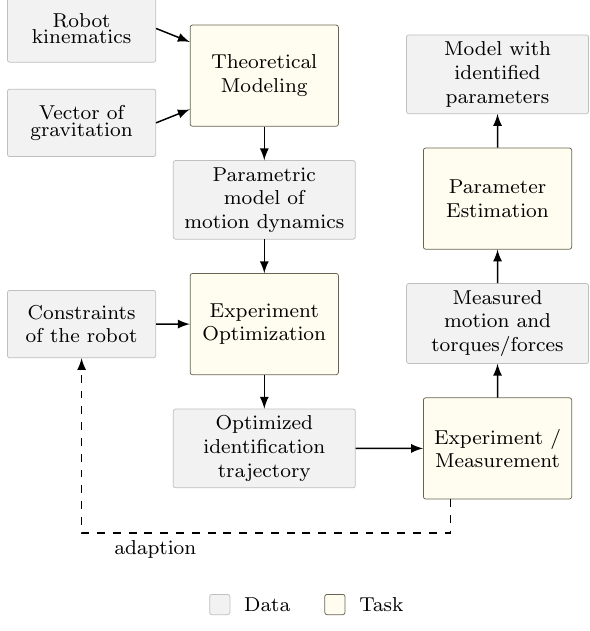
Fig. 3 Tasks and data flow used to model and identify robot dynamics